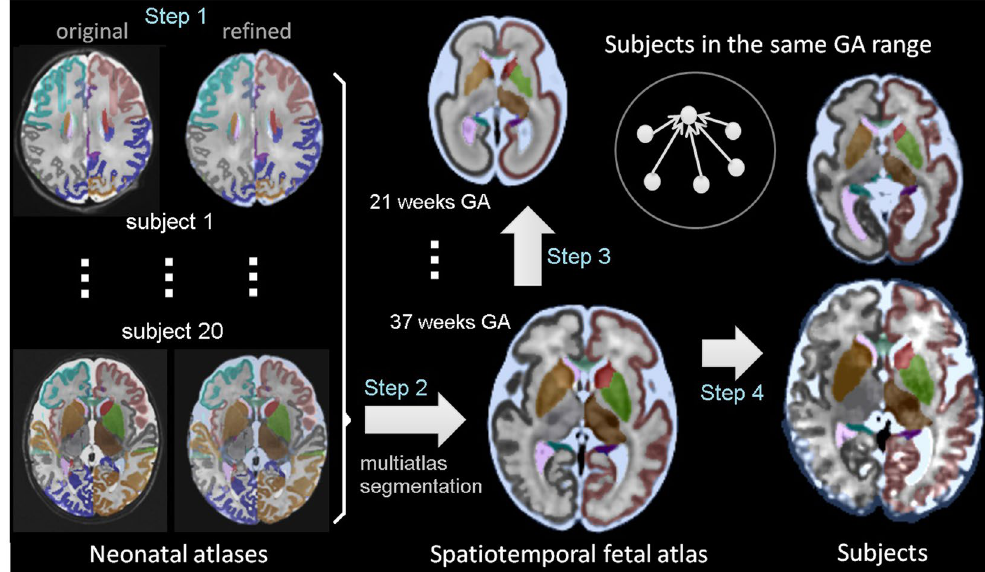
Figure 3. The procedure to generate atlas labels and segmentations: Step 1: labels and tissue-type segmentation of 20 neonatal ALBERTS atlases 66, 67 were refined manually. Step 2: The segmented neonatal atlases were used to generate initial labels on the spatiotemporal fetal brain MRI atlas at higher GAs (35–37 weeks) through multiatlas segmentation using probabilistic label fusion 65 . Step 3: Fetal brain MRI labels were manually defined and propagated in iterations from the higher GAs to the lower GAs. Step 4: Atlases within one week of any query subject were used to generate an initial segmentation of that subject. The initial segmentations of all subjects within one week of the query subject were used to segment that